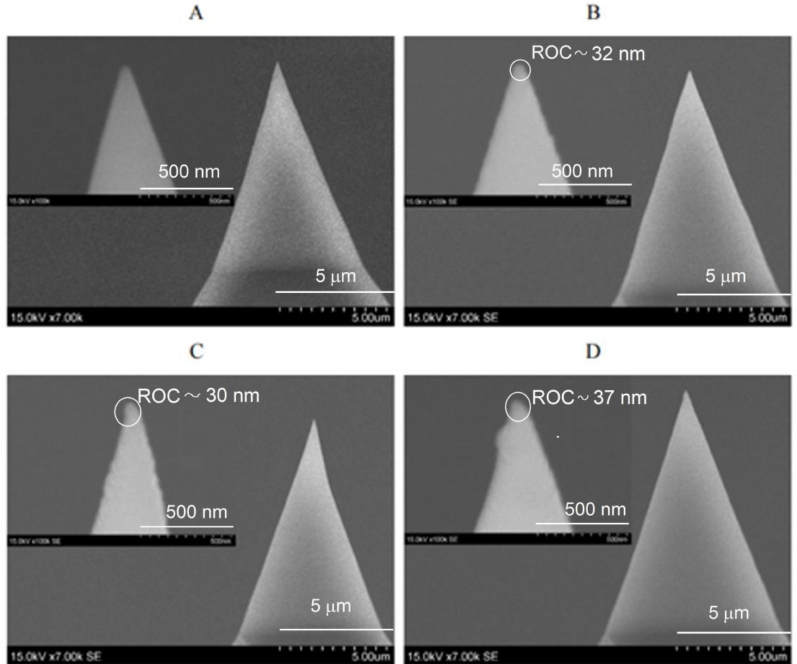
Figure 4. SEM images of uncoated Si tip ( A ) and three Si tips, separately coated with Au ( B – D ) under the same conditions of thermal evaporation in a vacuum. Magnification: ( A – D ) 7000 times and (insertions of ( A – D )) 100,000 times.